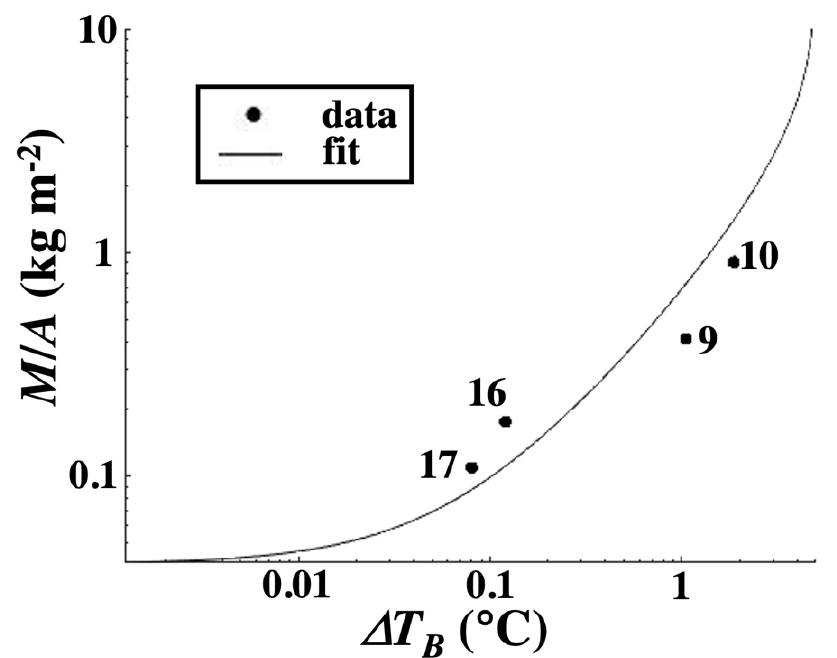
Figure 5. Brightness temperature contrast, Δ T B , versus the mass, M , to area, A , ratio, for calibration “collects” and asymptotic exponential fit. Data key and collect number (details in Table 1) on figure.